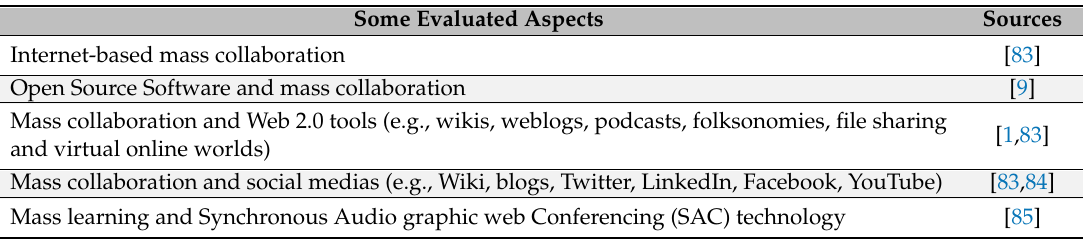
Table 8. Some examples of supportive tools, technologies, services, and web sites in mass